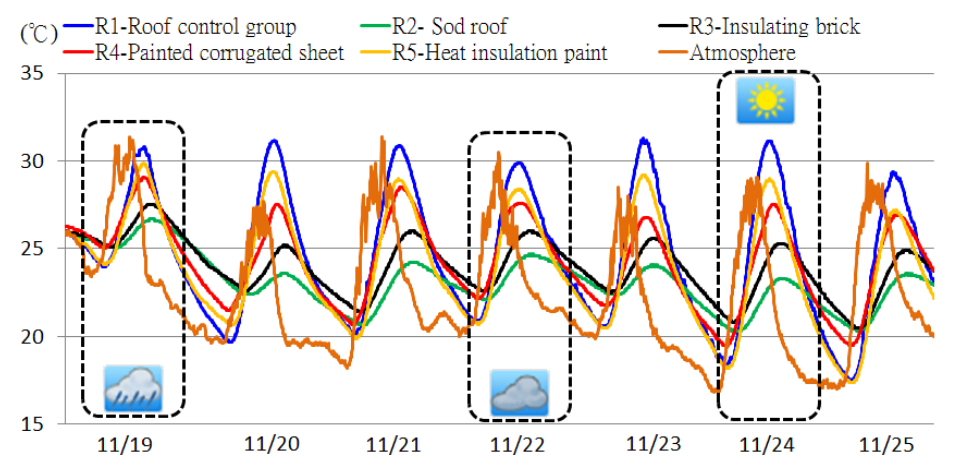
Figure 9. Efficacy measurements of roof thermal insulation